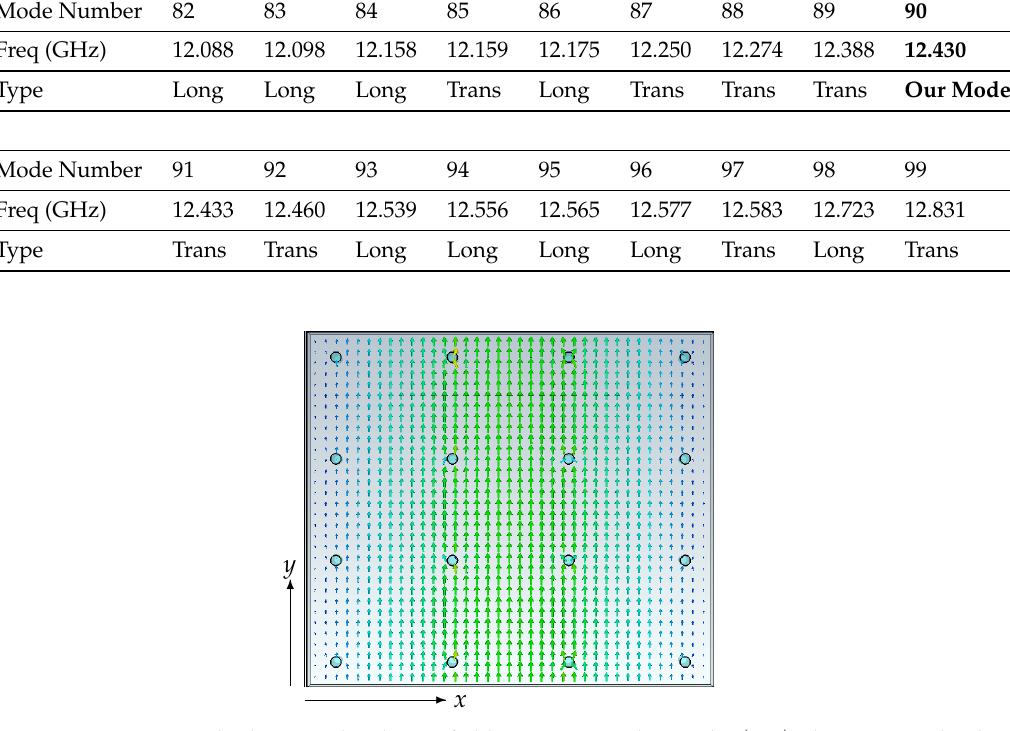
Figure 14. An example showing the electric field vectors on a slice in the ( x , y ) plane perpendicular to the wires. Most of the field modes near our desired longitudinal modes are of this transverse type, and should not be excited by a carefully designed (longitudinal) excitation field. The dimensions of the waveguide are the same as in Figure